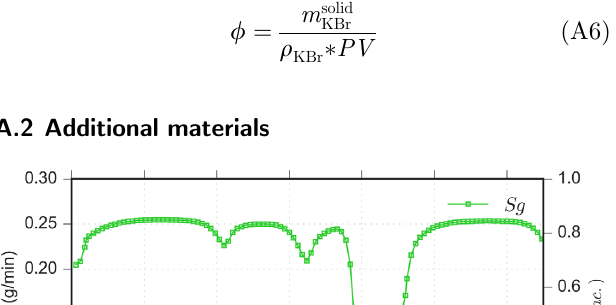
Fig. A3. Illustration of gas saturation, salt quantity and brine concentration computations from Neutron and X-ray measure- ments (red marker). Explanations are given in the